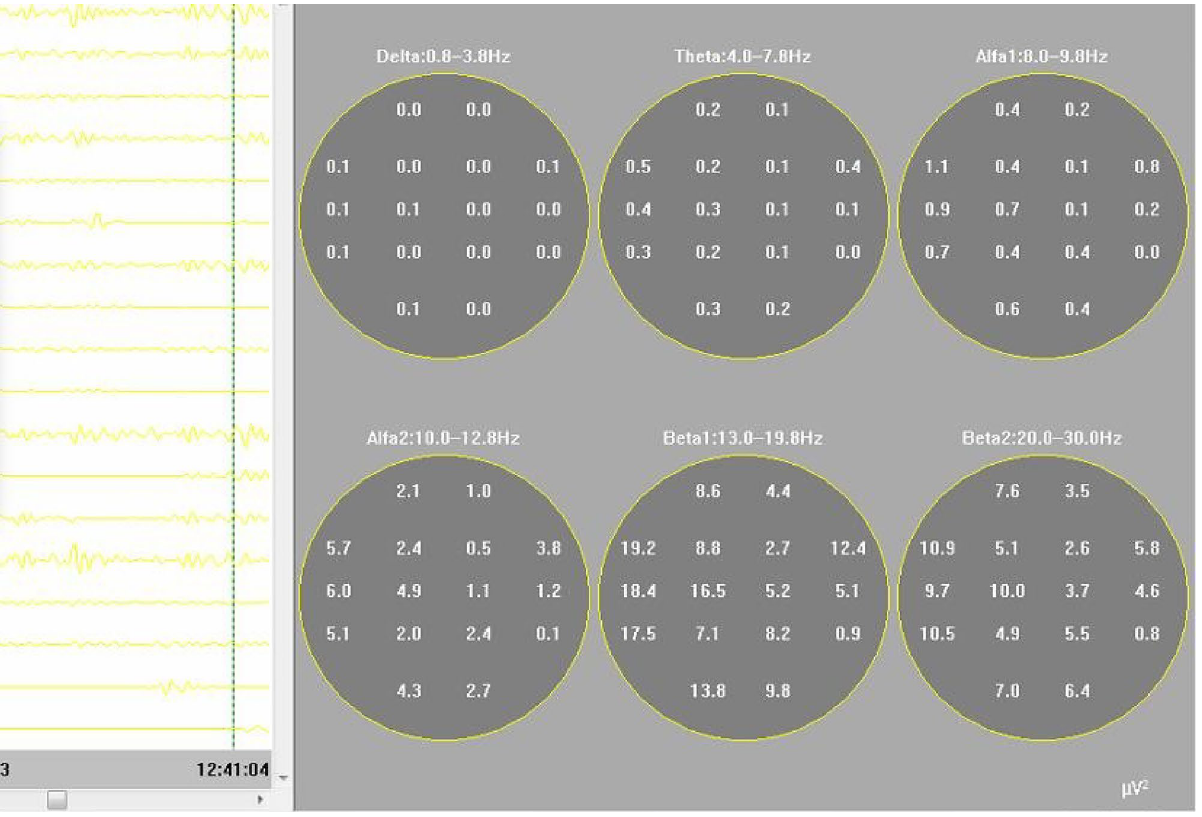
Figure 4. Numerical power intensity of the EEG wave form.